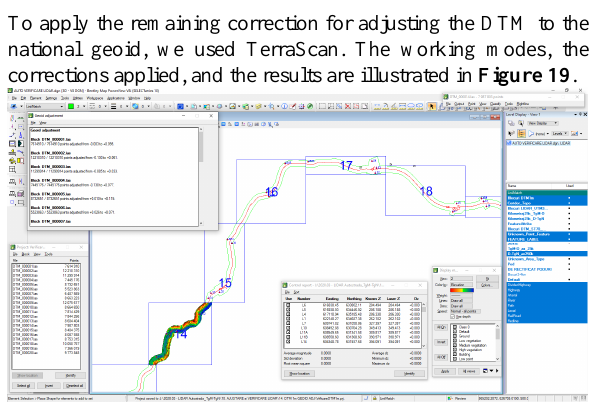
Figure 19 . Corrections applied and geoid adjustment results (Union Highway, km 50 - km 94)